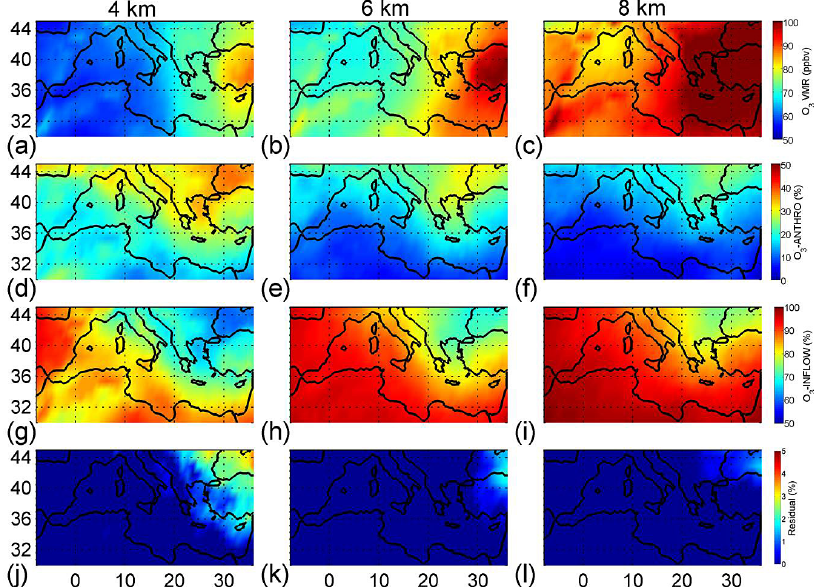
Figure 9. Same as Fig. 8 but for 4, 6, and